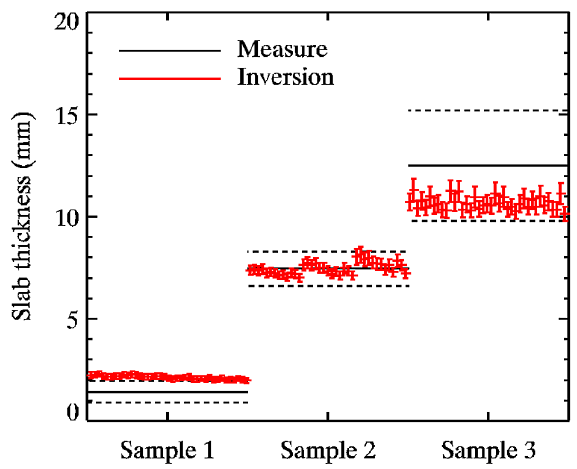
Figure 12. Results of the inversions and measurements with error bars at 2 σ for samples 1, 2 and 3, and for the 39 different geome- tries of measurement. The inversion points (in red) are sorted by incidence (three values), and each incidence is then sorted by az- imuth (13 values: one for emergence 0 ◦ and six each for the 10 and 20 ◦